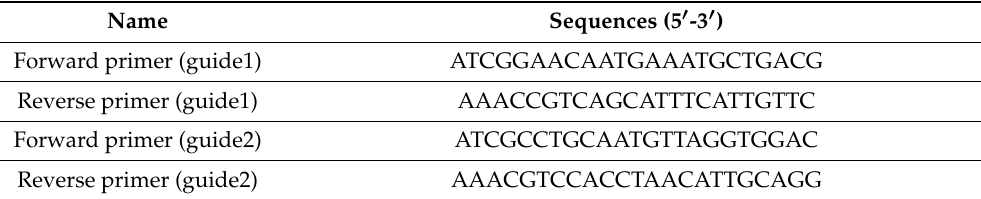
Table A1. Sequences of primers used in this